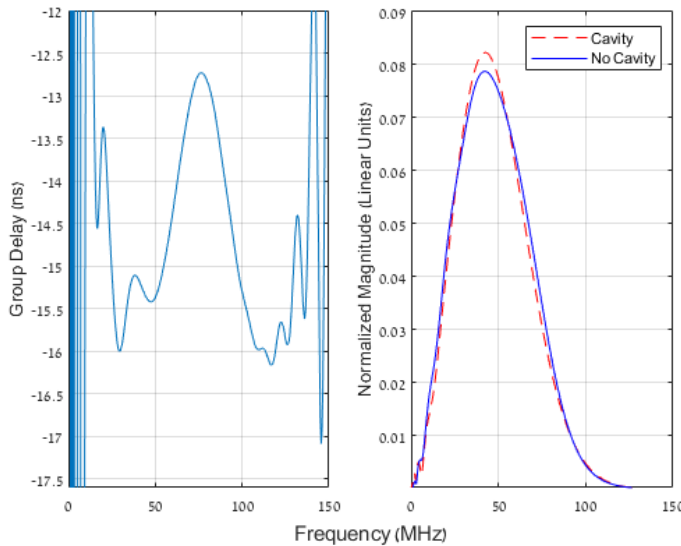
Figure 4. The group delay contributed by propagation through a two-meter-wide cavity, found using simulated measurements, and the magnitude spectra of the two simulated signals. Note that the results are expected to agree with those shown in Figure 3 only up to an additive